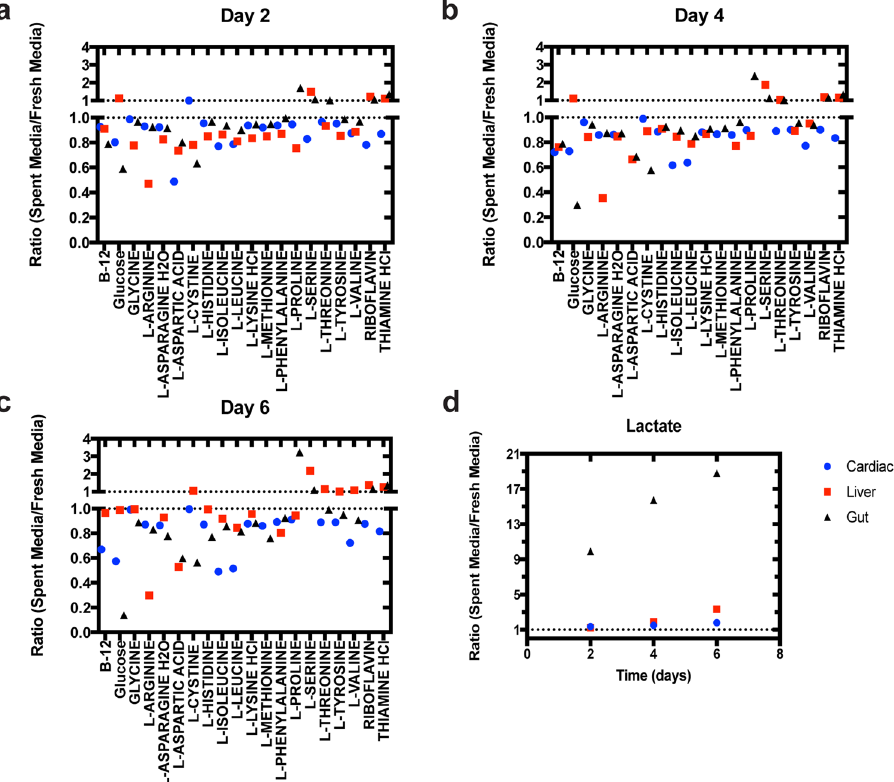
Figure 2. Identifying MPS-specific nutrient needs. Spent media components were profiled for gut MPS, cardiac MPS and liver MPS over six days. Changes in normalized medium component concentrations (spent medium/ fresh medium) for all MPSs (black triangles: gut; red squares: liver; blue circles: cardiac; symbols represent average over three biological replicates) were evaluated at day 2 ( a ), day 4 ( b ) and day 6 ( c ). Changing lactate levels were plotted separately for visual purposes ( d ). Concentrations of components in spent media were normalized to fresh media concentrations such that values below 1 indicate net consumption and above 1 indicate net